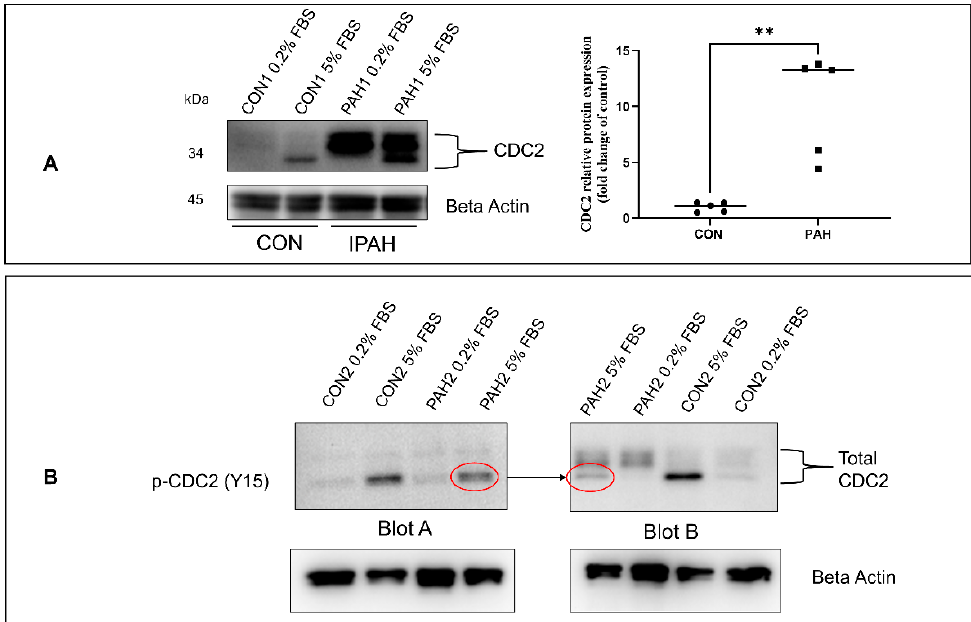
Figure 1. Overexpression of CDC2 in PAH HPASMC. ( A ) Western blot showing CDC2 protein expression in PAH and non-PAH donor control HPASMC under 0.2% FBS and 5% FBS growth conditions. Scatter plot representing relative CDC2 protein levels in n = 5 non-PAH and n = 5 PAH HPASMC grown in 0.2% FBS medium. ( B ) Blots show the proper size of p-CDC2 (Tyr15) compared to total CDC2 bands. Duplicates of the same samples were run on a single SDS-PAGE and transferred onto a single blot. The blot was then cut into sections A and B with each containing one set of the duplicate samples. Blot A was probed for p-CDC2 (Y15) and Blot B was probed for total CDC2. The arrow points to the same migratory distance (molecular weight) indicated by red circles between Blot A and Blot B. Images are representative of at least duplicate experiments. **- p < 0.01.